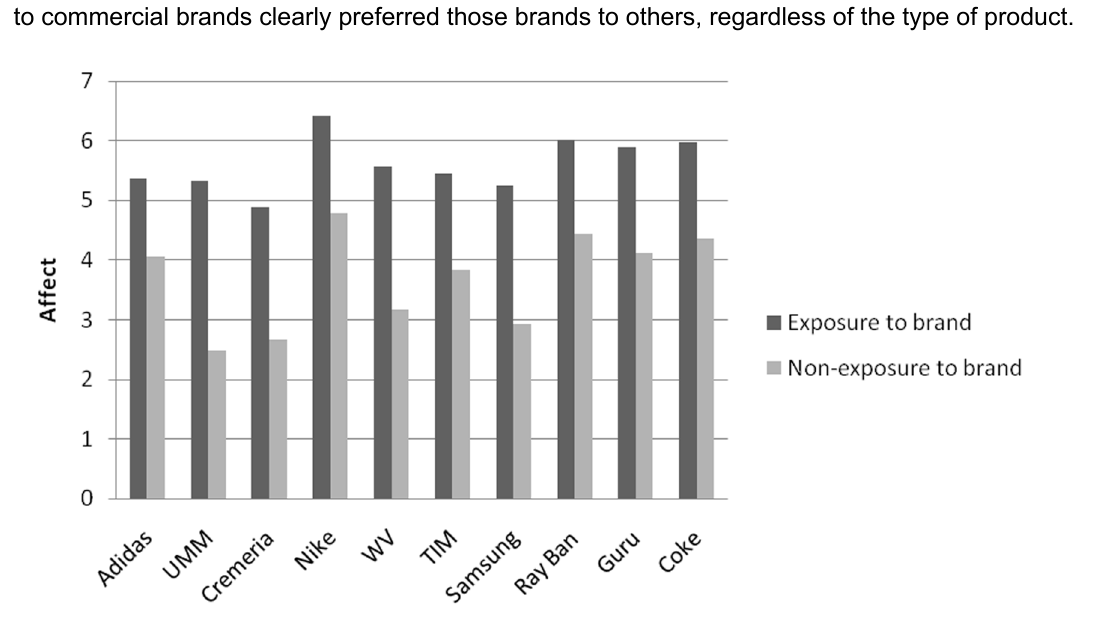
Figure 1. Level of